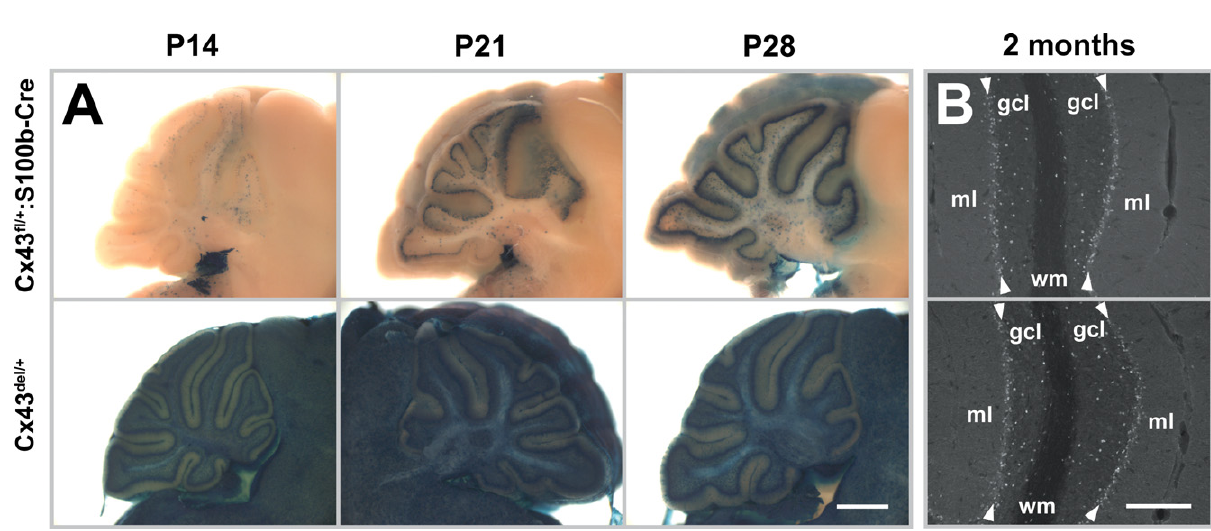
Figure 5. Time course of S100b-Cre -mediated deletion of Cx43 fl allele in the postnatal cerebellum. (A) Cre-mediated recombination was assayed by whole mount lacZ staining of parasagittal brain slices from Cx43 fl / + :S100b-Cre mice and positive control Cx43 del/ + mice at P14, P21, and P28. No lacZ-positive cells were detected in negative control Cx43 fl / + mice at those stages (data not shown). Scale bar, 1 mm. (B) Immunofl uorescence analysis of parasagittal sections of the cerebellum from 2-month-old Cx43 fl / + :S100b-Cre mice and positive control Cx43 del/ + mice using antibodies directed to β -galactosidase. β -galactosidase immunoreactivity was localized in the nucleus. Arrowheads indicate Purkinje cell layer. gcl, granule cell layer; ml, molecular layer; wm, white matter. Scale bars, 200